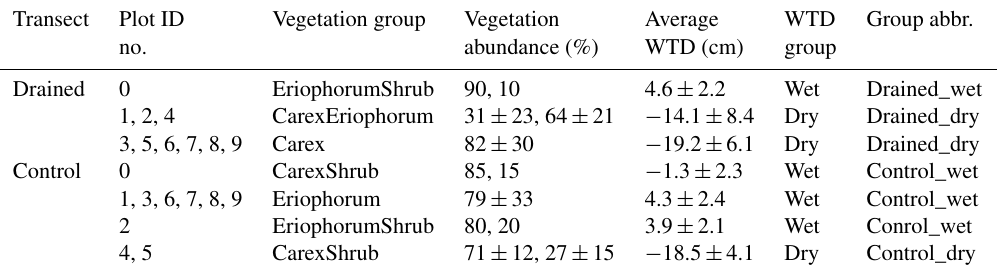
Table 2. WTD and vegetation characteristics of plots. Vegetation groups were created by taking into account only Carex sp., E. angustifolium , and shrubs when the relative abundance of each species exceeded 10%. The relative abundances of consisting plant species (mean ± SD) are separately presented. Average WTD was calculated by pooling all WTD measurements from both years (mean ± SD), except the period where the whole area was flooded from snowmelt. When the average WTD of the growing season was larger than − 10cm, plots were classified as wet groups. Transect Plot ID Vegetation group Vegetation Average WTD Group abbr. no. abundance (%) WTD